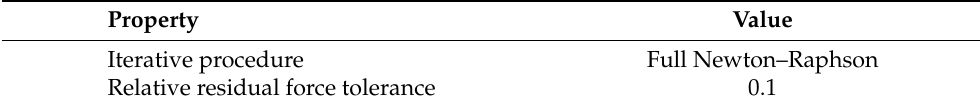
Table A1. Non-linear solver convergence properties.